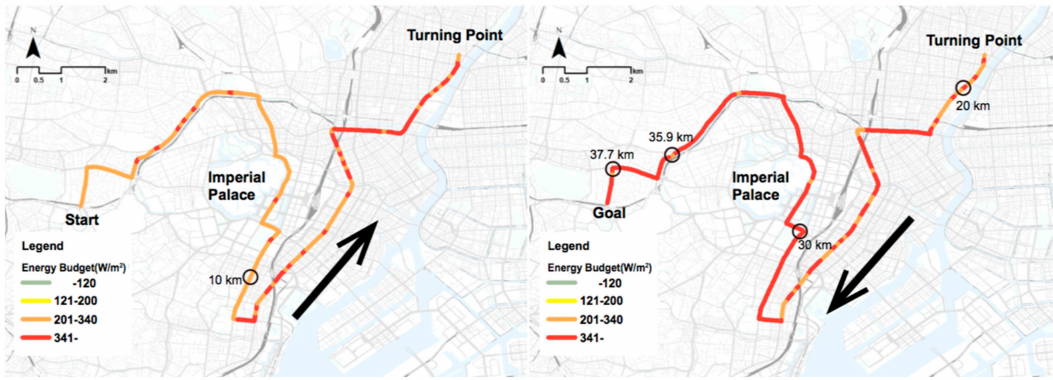
Figure 5. Energy budget for the worst-case scenario mapped on the marathon route (left: outward; right: homeward).